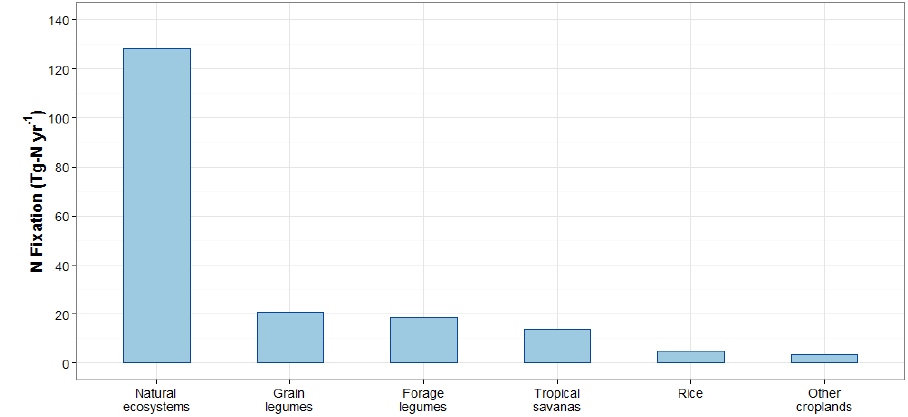
Figure 1. Summary of estimated global terrestrial contributions to biological N fixation in 2000. Values in TgNyr − 1 (based on Table 1 and activity